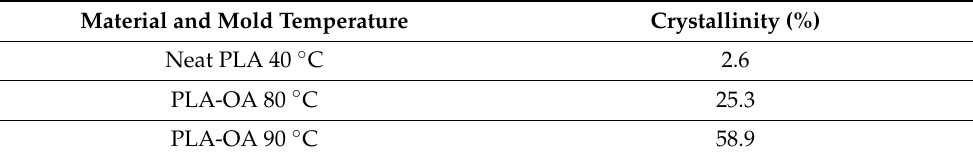
Table 5. Crystallinity of injection molded samples with neat PLA and PLA-OA blend.